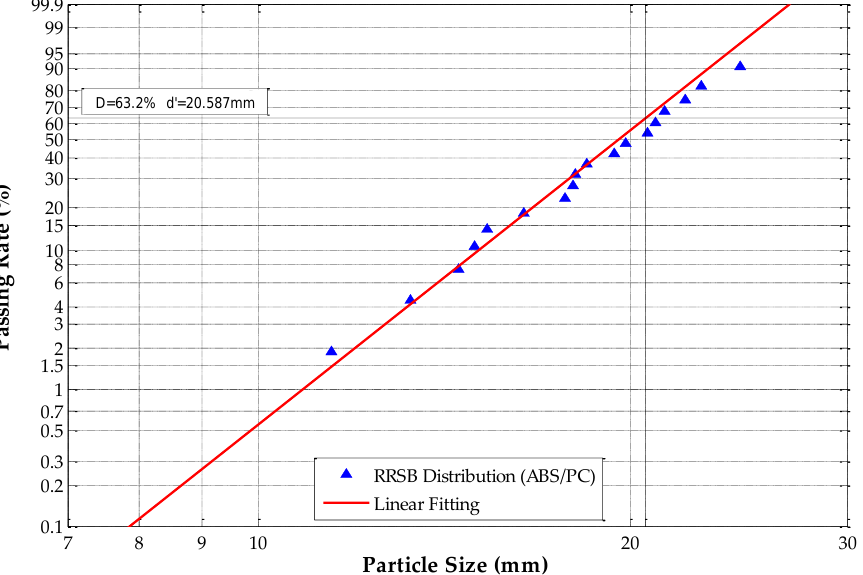
Figure 9. RRSB distribution of acrylonitrile-butadiene-styrene/polycarbonate (ABS/PC) samples.